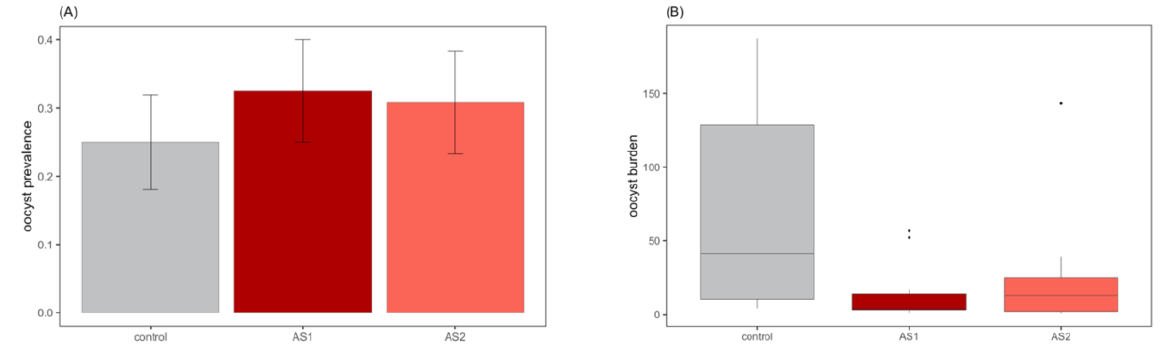
Figure 3: Experiment 2. Mean (± s.e) oocyst prevalence ( A ) and burden ( B ) in mosquitoes infected by each parasite line 8-9 days post infection. Burden is represented as a boxplot showing the median (horizontal lines), and the first and third quartiles (box above and below the medians). Vertical lines delimit 1.5 times the inter-quartile range above which individual counts are considered outliers and marked as